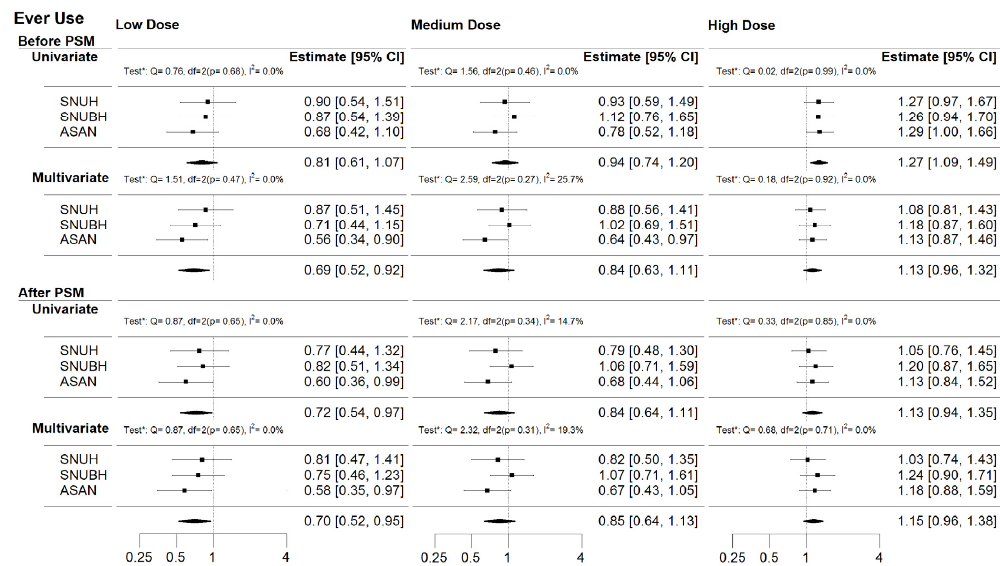
Figure 3. The overall dose-response effect of HCTZ use on NMSC in the CDM network for “Ever use”. Each analysis was tested for heterogeneity (“Test*” indicates Cochran’s Q and I 2 value tests). In the significant associations, the chi-square tests for heterogeneity in most cases were insignificant and its